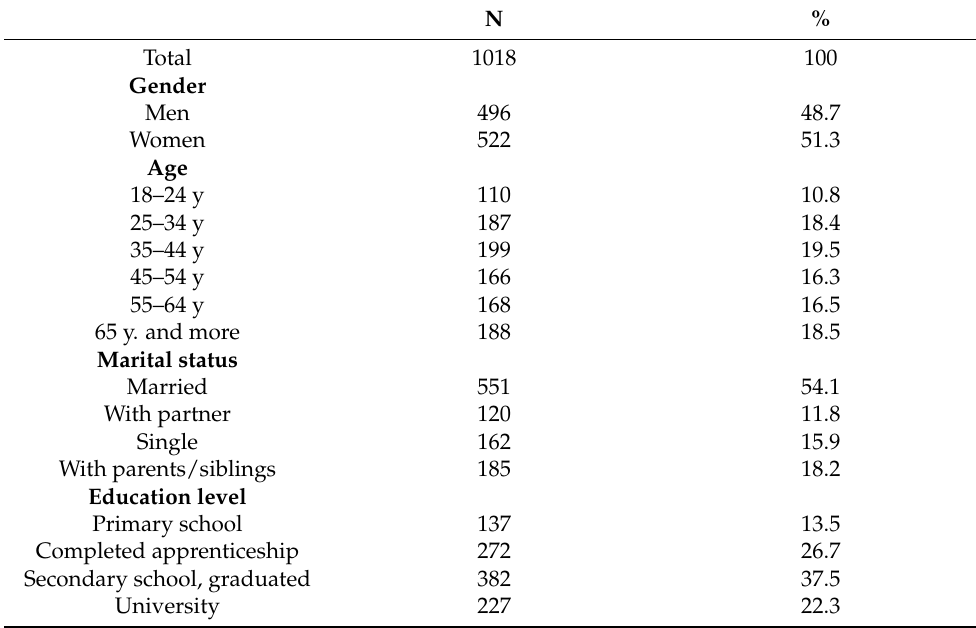
Table 1. Description of the research